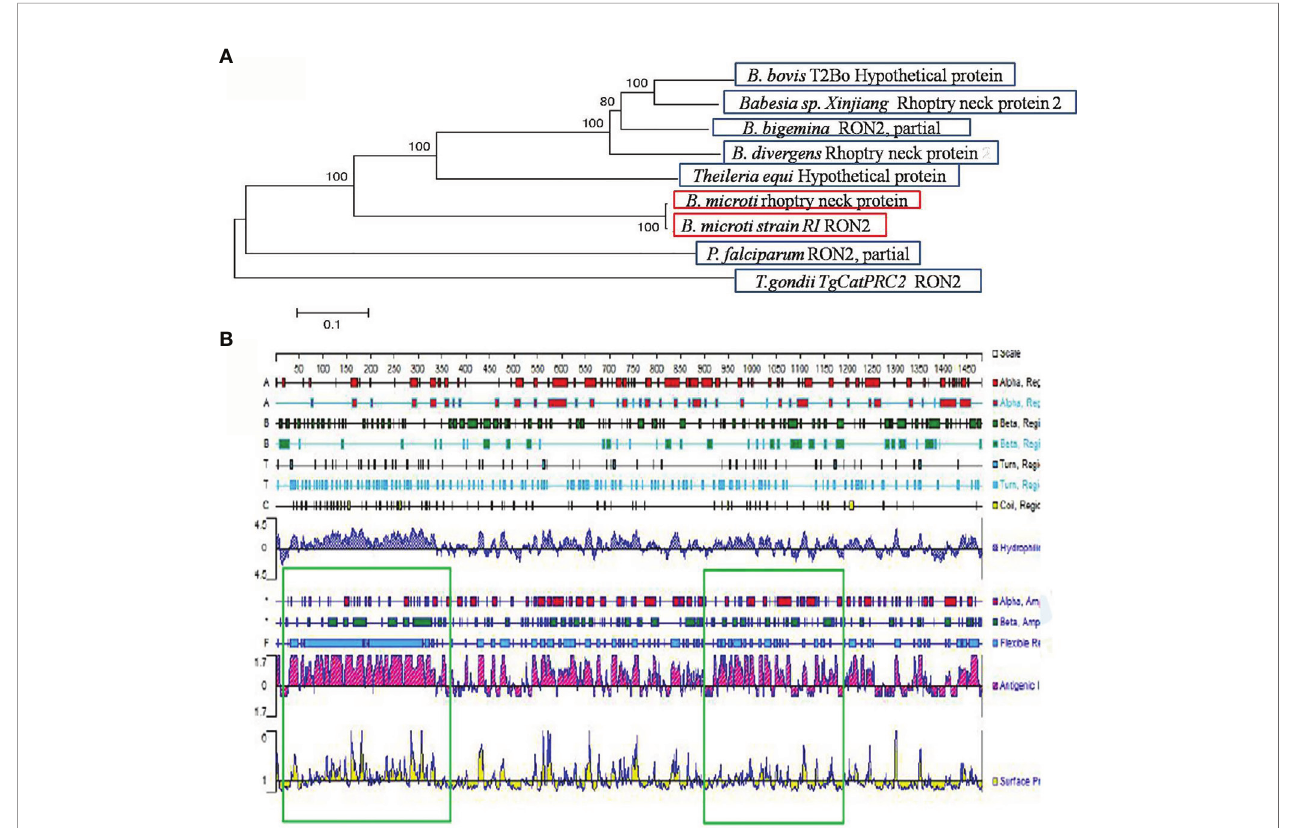
FIGURE 1 | Gene analysis of BmRON2. (A) Apicomplexa rhoptry neck protein 2 sequence dendrogram. The dendrogram was constructed using the neighbor- joining method. Bootstrap analysis was performed with 1,000 replicates. (B) Signal peptide prediction results for rhoptry neck protein 2. The green boxes show the two truncated protein